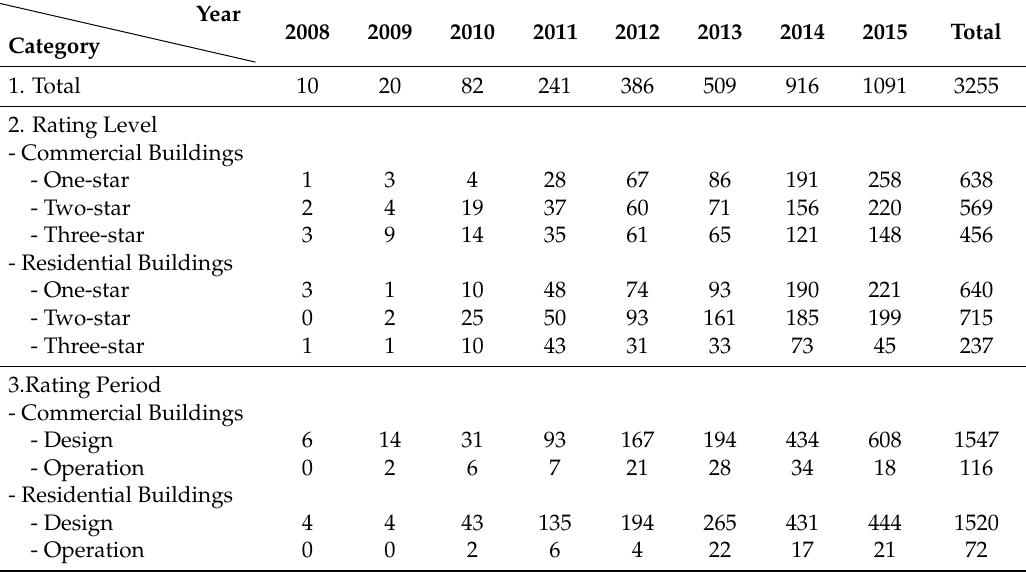
Table 1. Number of green buildings in